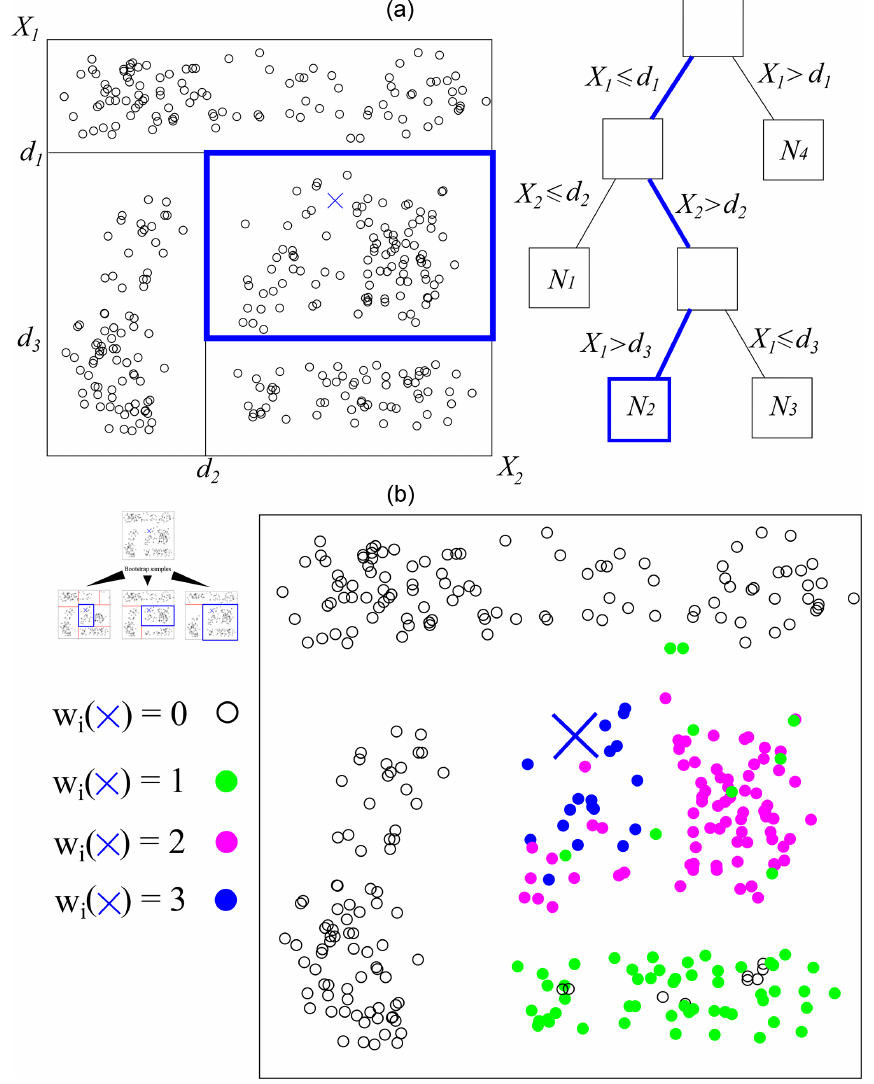
Figure 4. Two-dimensional example of a (a) binary regression tree and (b) three-tree forest. A binary decision tree is built from a bootstrap sample of the data at hand. Successive dichotomies (lines splitting the plane) are made according to a criterion based on observations’ homogeneity. For a new set of predictors (the blue cross), the path leading to the corresponding observations is followed. The predicted CDF is the aggregation of the results from each